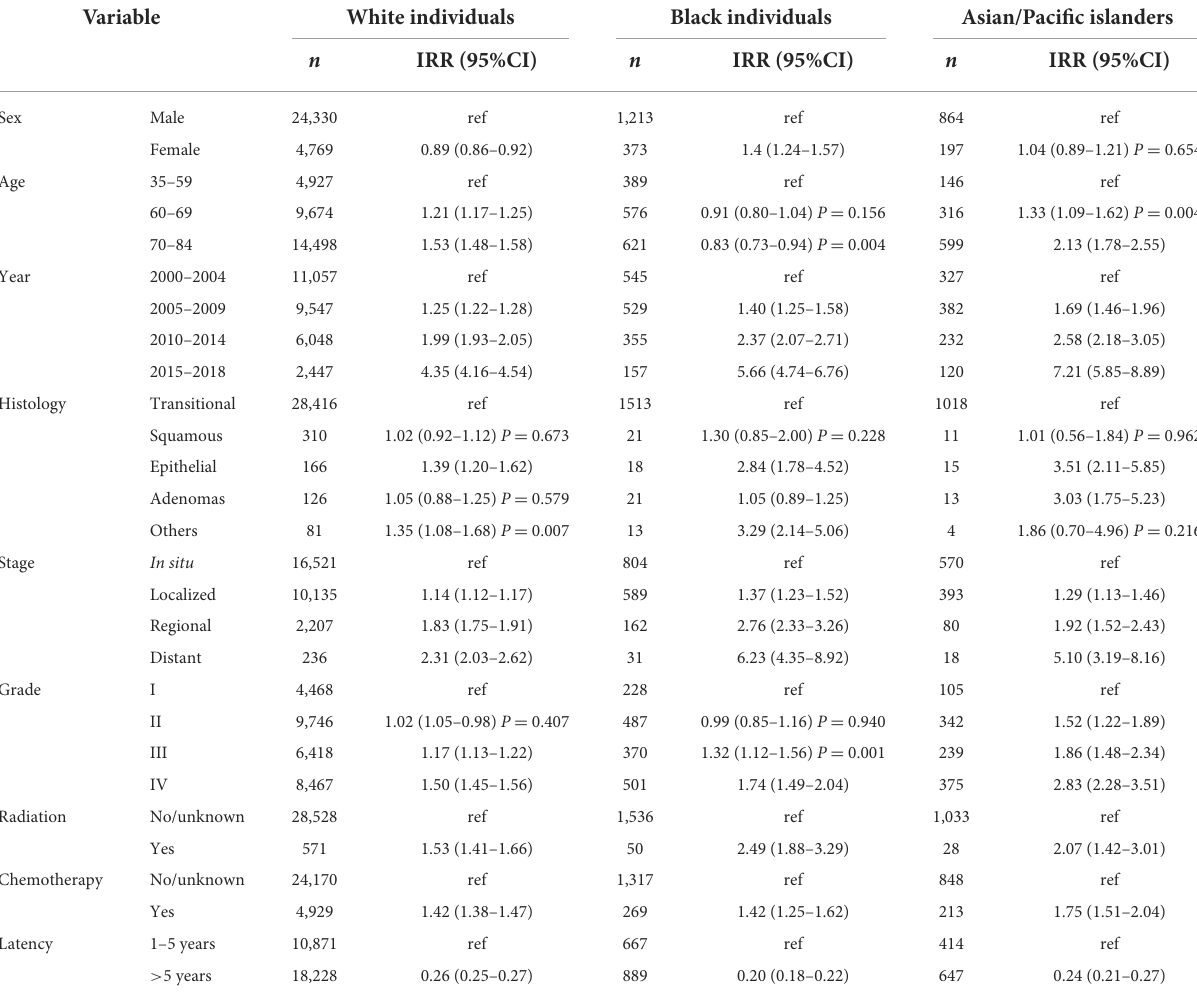
TABLE 2 SPM cases by race using the IRR, with 95% CI; only p > 0.001 are